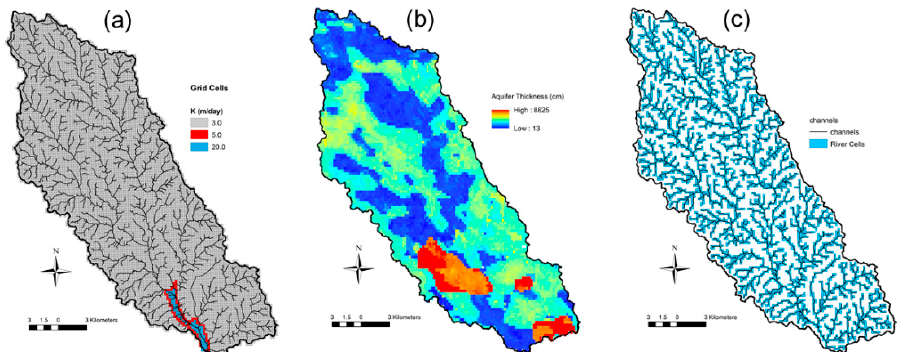
Figure 5. ( a ) gwflow grid cells showing SWAT+ channels and final hydraulic conductivity (m/day) values; ( b ) aquifer thickness (cm); and ( c ) grid cells designated as River Cells (i.e., cells that can exchange water with SWAT+ channels).